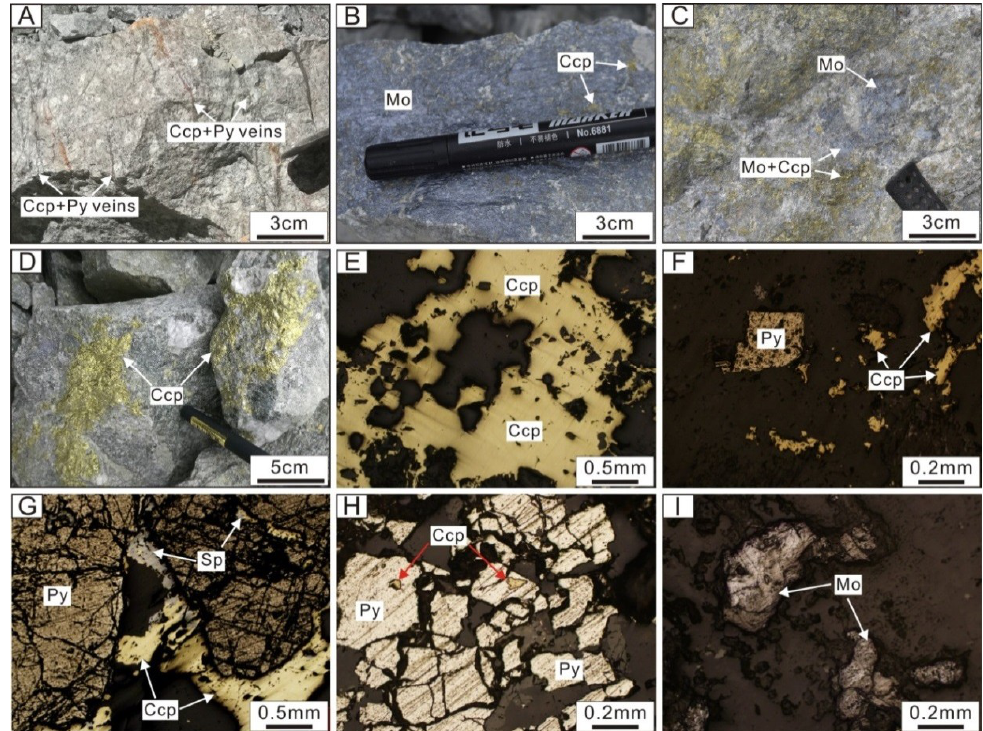
Figure 4. Photographs of ore fabrics and mineral assemblages of the Pulang porphyry Cu (–Mo–Au) deposit. ( A ) Chalcopyrite–pyrite veins and veinlets are distributed in the altered quartz monzonite porphyry. ( B ) Thin-film molybdenite veinlet. ( C ) Chalcopyrite intergrown with molybdenite that occurs as dense-disseminated in the altered quartz monzonite porphyry. ( D ) Nodular chalcopyrite. ( E ) Xenomorphic granular chalcopyrite. ( F ) Idiomorphic granular pyrite and xenomorphic granular chalcopyrite. ( G ) Chalcopyrite replaced by sphalerite, and they were filled into the fissures of pyrite. ( H ) Pyrite showing a cataclastic texture; and chalcopyrite filling into the holes of pyrite. ( I ) Scaly molybdenite. Abbreviations: Ccp: chalcopyrite; Py: pyrite; Mo: molybdenite; Sp: sphalerite.